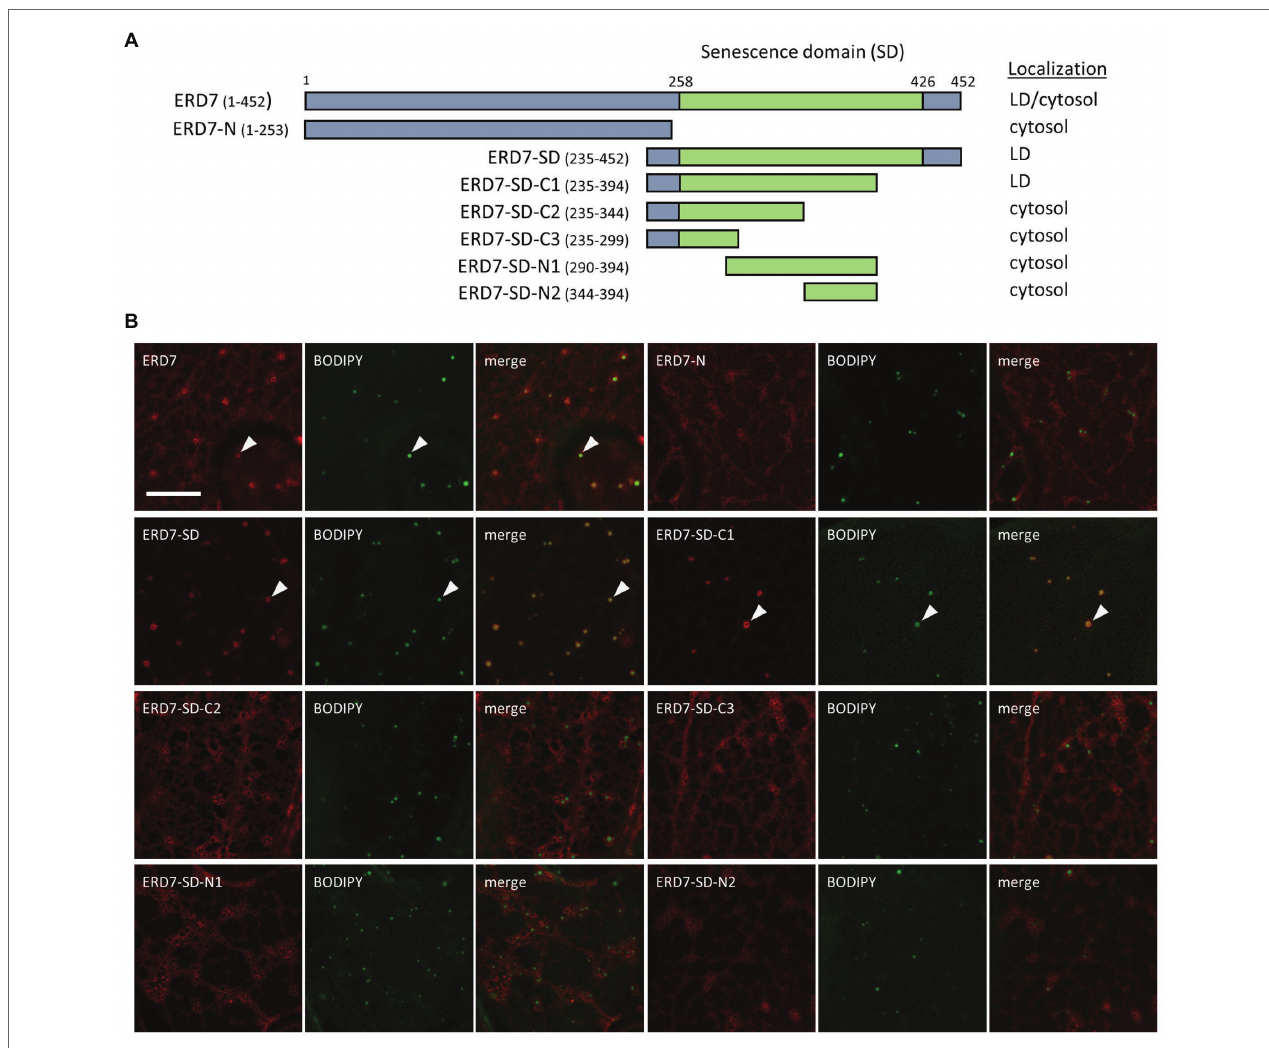
FIGURE 2 | Subcellular localization of various ERD7 truncation mutants in N. benthamiana leaves. N. benthamiana leaves were transiently transformed ( via Agrobacterium infiltration) with either full-length or truncated versions of ERD7 and tagged at their N-termini with mCherry. Three days post-infiltration, leaves were stained with the neutral lipid dye BODIPY and imaged using CLSM. Shown in (A) are schematic representations of full-length ERD7 and the various ERD7 mutants and their corresponding subcellular localization(s) [i.e., cytosol and/or lipid droplet (LD)]. Numbers above the illustration of full-length ERD7 represent specific amino acids residues, and the SD (amino acid residues 258–426) is defined based on information obtained from the InterPro database. The numbers next to the name of each construct denote the amino acid residues in ERD7 that were fused to mCherry; note that the N-terminal-appended mCherry moiety is not depicted in the illustrations or construct names. The portion of ERD7 representing the SD or the other parts of the protein are depicted in the illustrations as green or gray boxes, respectively. Shown in (B) are representative CLSM images (z-sections) of each mCherry-ERD7 (mutant) protein, as indicated by the panel labels, along with the corresponding BODIPY-stained LDs in the same cell. Also shown is the corresponding merged image. Arrowheads indicate examples of mCherry-ERD7 and the selected (mutant) versions thereof (i.e., ERD7-SD and ERD7-C1) that localized to BODIPY-stained LDs; compare with the lack of LD localization for the other mutant versions of ERD7. Scale bar in (B) = 10 μ